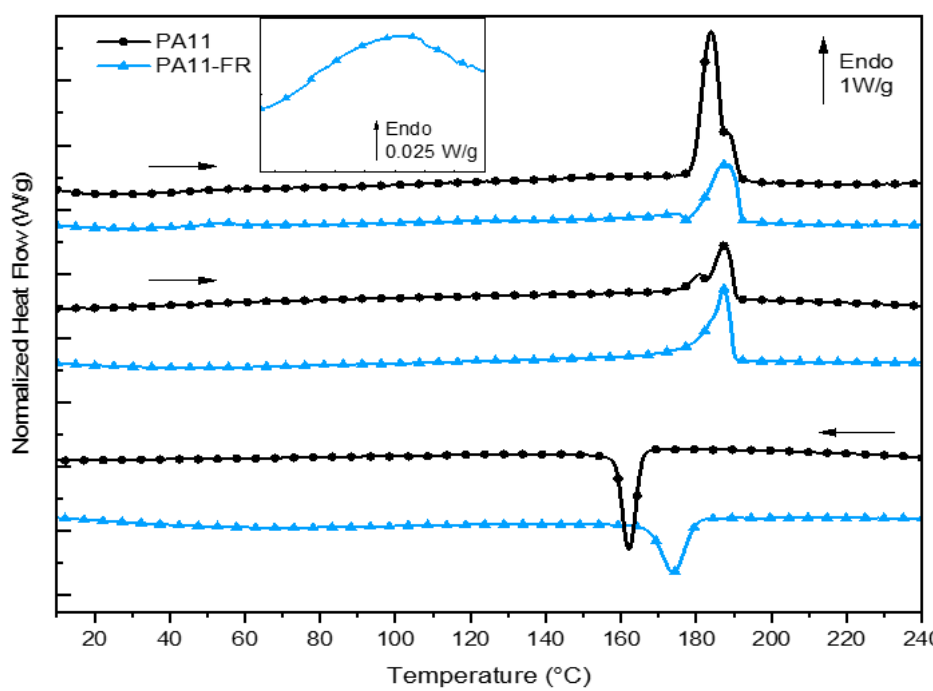
Figure 3. DSC curves of PA and PA11-FR and zoom-in the PA11-FR glass transition. Table 2. Thermal characteristics of PA11 and PA1-FR.